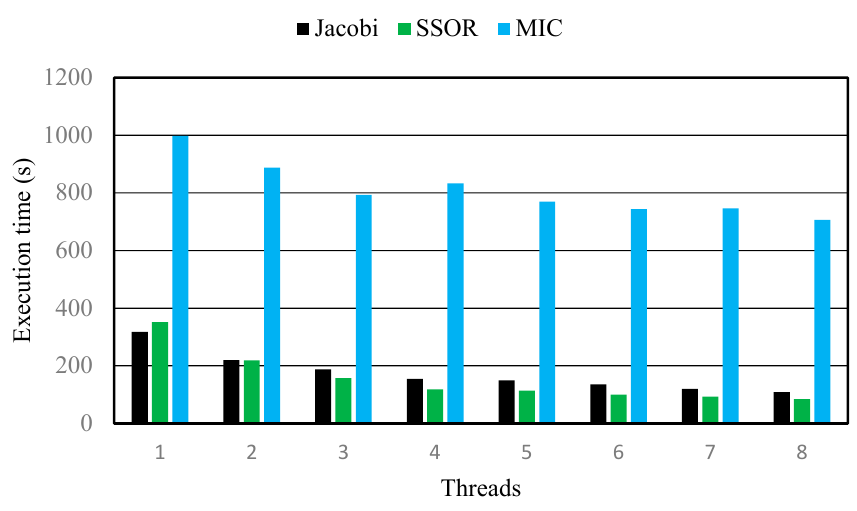
Figure 7. Execution time vs. number of threads for different preconditioning options.